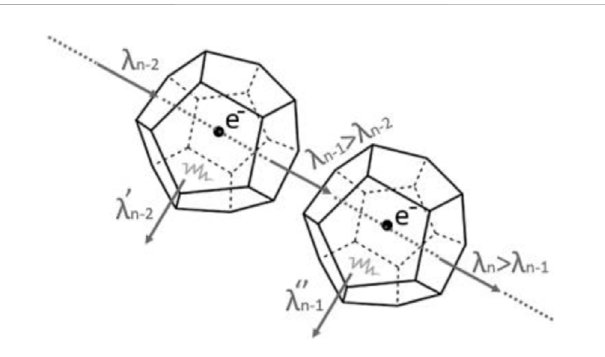
FIGURE 3 Schematization of Weigner – Seitz electron crystals centered on electrons. No scattering process occurs. The incoming photon of light undergoes a redshift due to absorption and re-emission by the system electroncrystal. Secondaryphotonsoriginatefromtherecoilofthe electron crystals and undergo the same